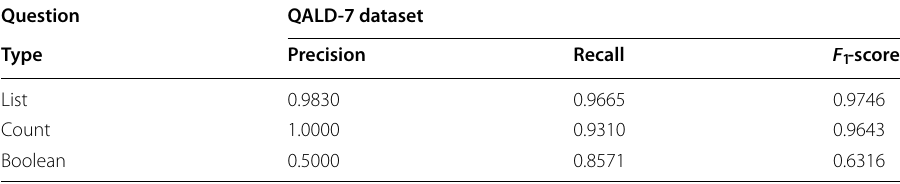
Table 4 Question type classification performance on QALD-7 dataset Question